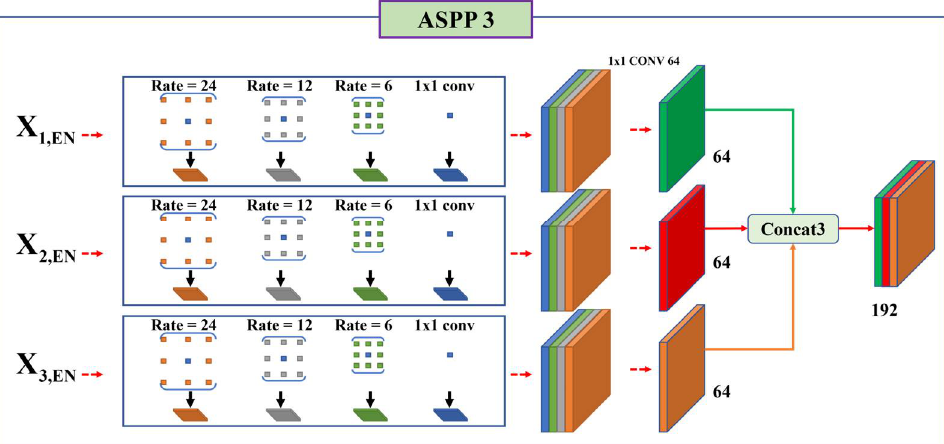
Figure 11. CNN with ASPP. ( a ) Classical CNN structure, ( b ) encoder–decoder CNN structure.